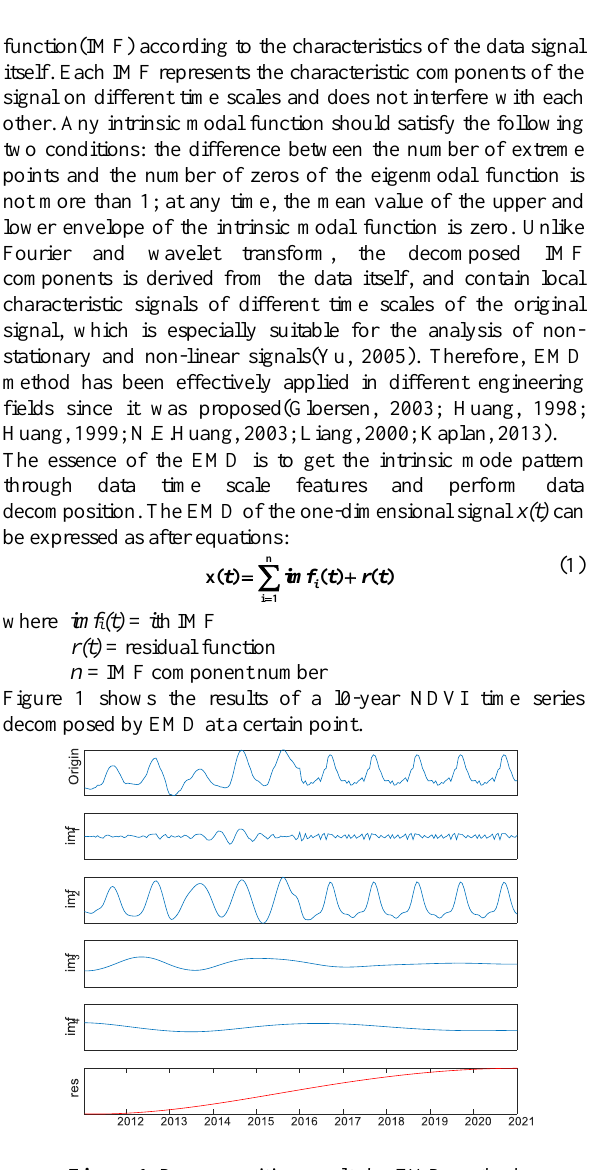
Figure 1. Decomposition results by EMD method